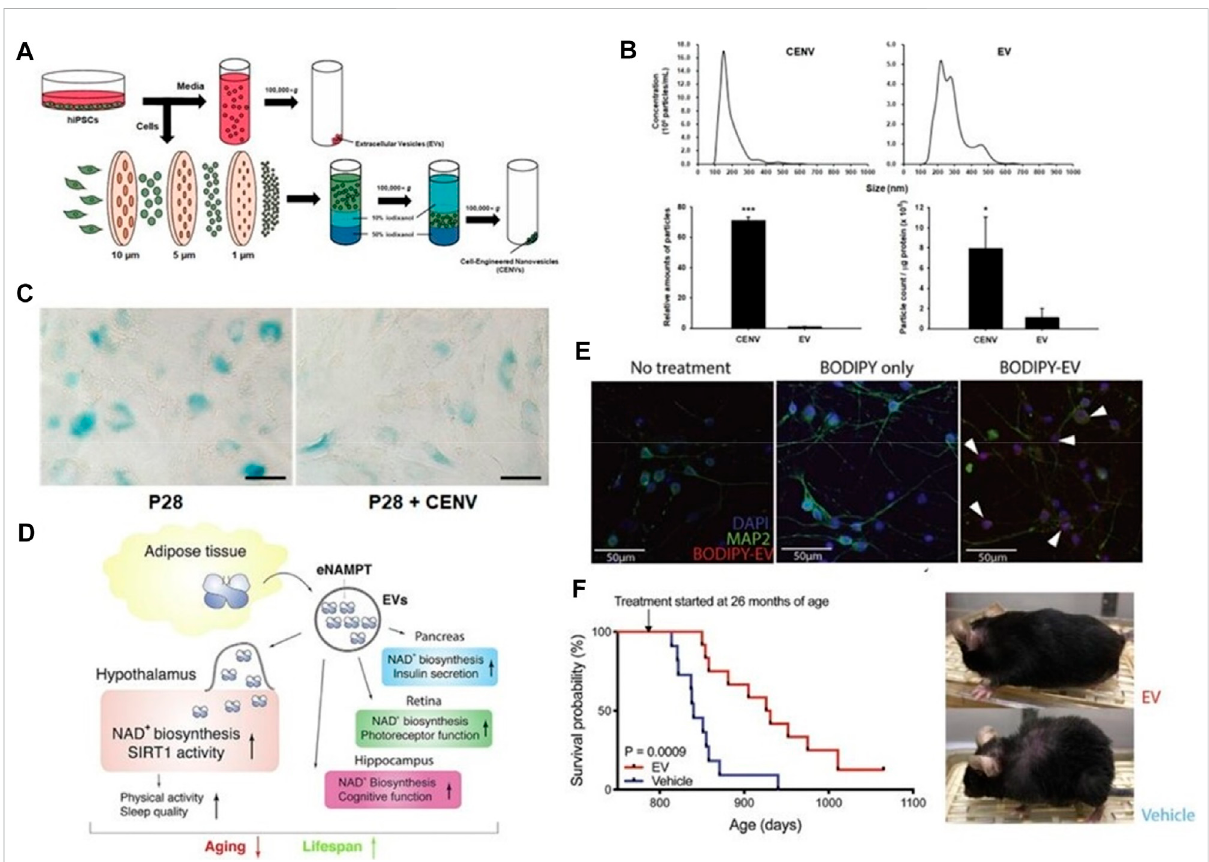
FIGURE 6 Exosomes delay cell senescence. (A) Schematic of the preparation of extracellular vesicles (EVs), and cell-engineered nanovesicles (CENVs) from human induced pluripotent stem cells (iPSCs). (B, C) Comparison of human iPSC-derived CENV and EV (Lee H. et al., 2020). (D) Mechanism Diagram of eNAMPT Containing Extracellular Vesicles Delaying Cell Aging. (E) Fluorescent images of primary hypothalamic neurons following the incubation with BODIPY-labeled EVs. (F) Kaplan-Meier curves and representative images of aged female mice injected with vehicle or EVs isolated from 4- to 12-month-old mice ( n = 11 – 12). The mouse images were taken after 3 months of treatment (Yoshida et al.,